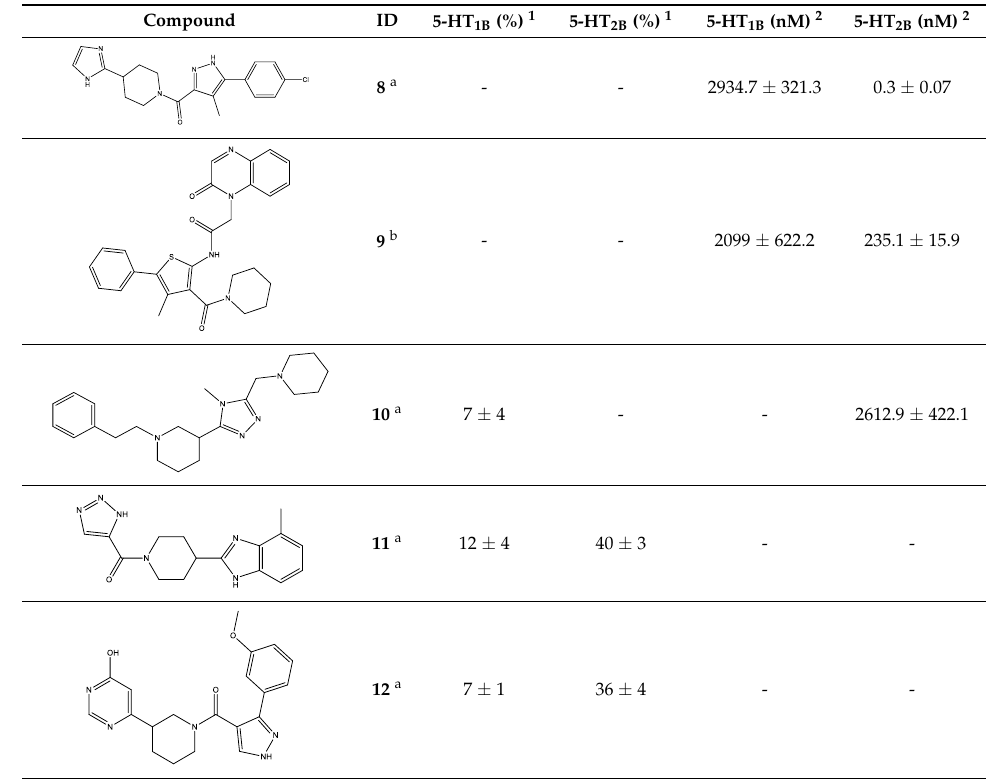
Figure 5. Residues (red) used in pose filtering for 5-HT 1B R (PDB ID: 4IAQ) panel ( A ) and 5-HT 2B R X-ray structures (PDB ID: 4IB4) panel ( B ); Water molecules forming interactions with the Asp 3.32 shown as a sphere representation. Table 2. Structures and measured in vitro assay data of top-ranked compounds (sorted by percentage of inhibition and K i (nM) in h5-HT 2B R competition binding assay). Values represent the mean ± SD of three independent assays with duplicate measurements.